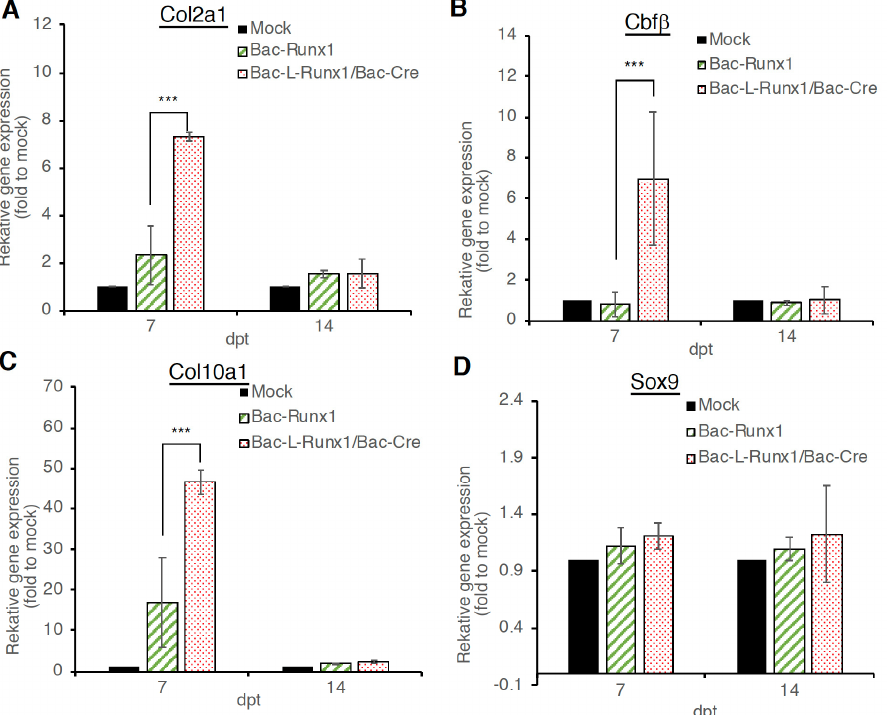
Figure 4. Chondrogenic markers expression at Bac-L-Runx1/Bac-Cre transduced BMSCs. ( A ) Collagen type 2A1 (Col2a1) mRNA expression. ( B ) Cbf β mRNA expression. ( C ) Collagen type 10A1 (Col10a1) mRNA expression. ( D ) Sox9 mRNA expression. BMSCs were transduced with Bac-Runx1 or Bac-L- Runx1/Bac-Cre and compared with mock-transduction. Cells were collected at 7- and 14-dpt. ( n = 3) *** p < 0.001.